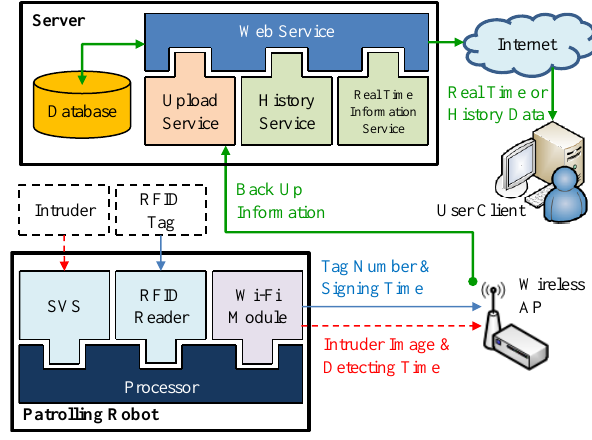
Figure 8. Architecture of remote data backup and querying system.